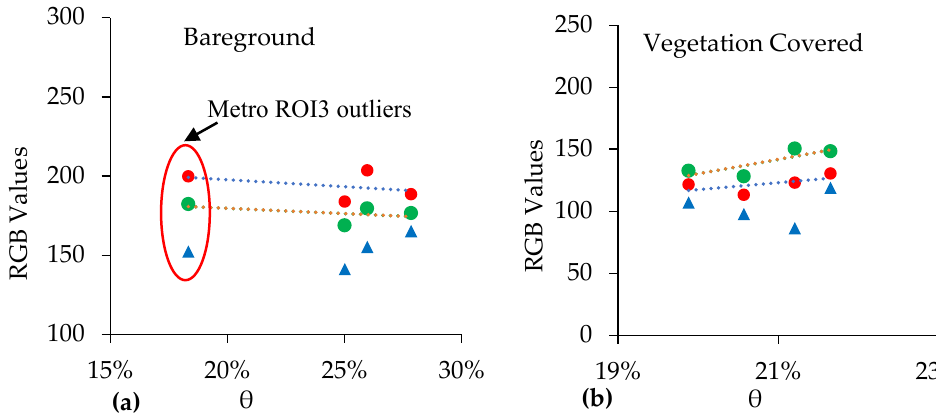
Figure 7. RGB avg variation with θ for all sites. ( a ) Bare ground class pixels. ( b ) Vegetation covered class.